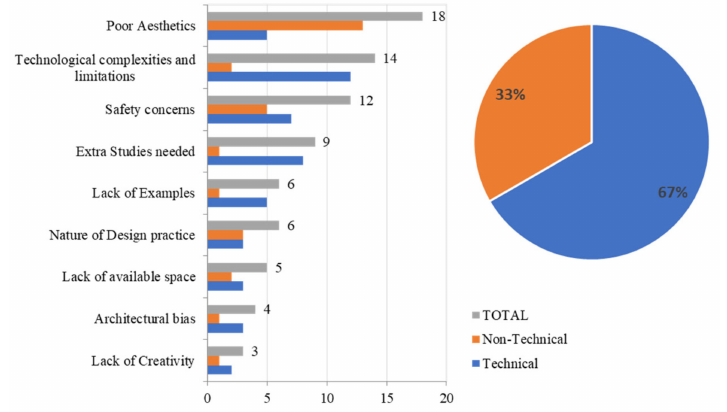
Figure 5. Social barrier sub-themes with the number of participants who commented.